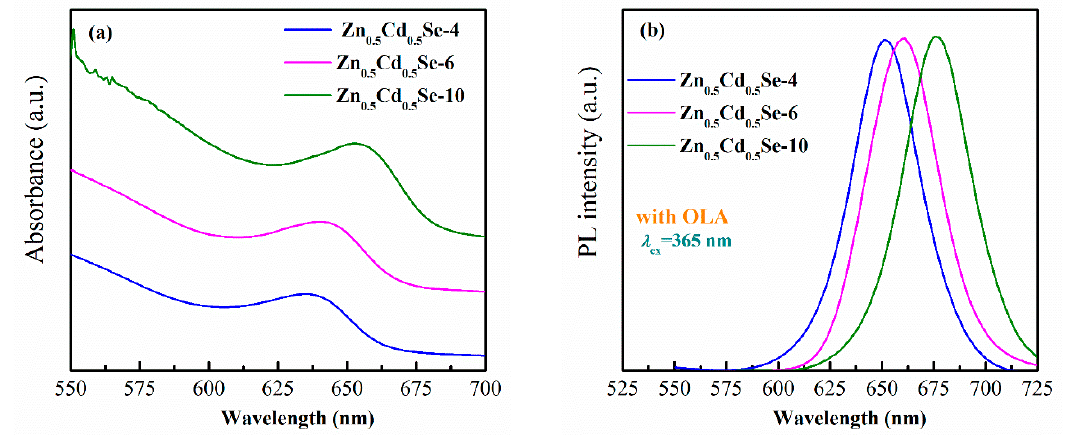
Figure 8. Influence of the high OLA content on the ( a ) UV-vis absorption spectra and ( b ) PL spectra of Zn 0.5 Cd 0.5 Se alloy QDs.